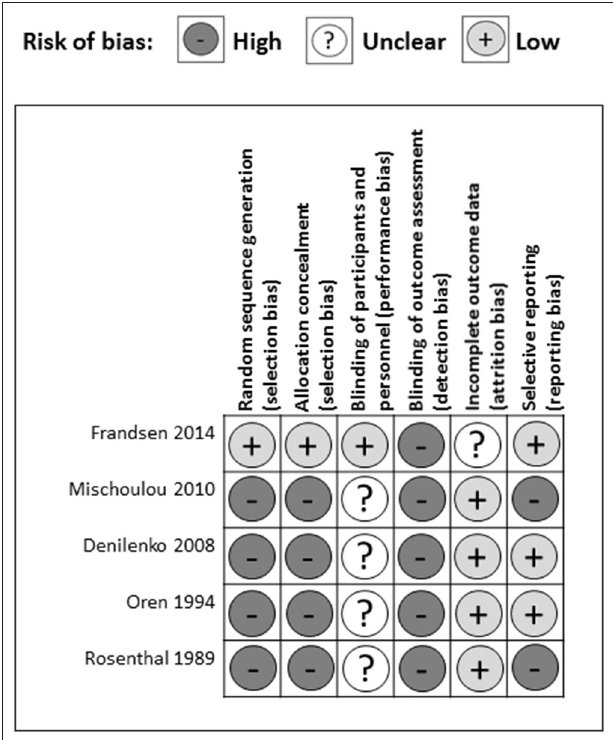
FIGURE 4 | Risk of bias assessment for